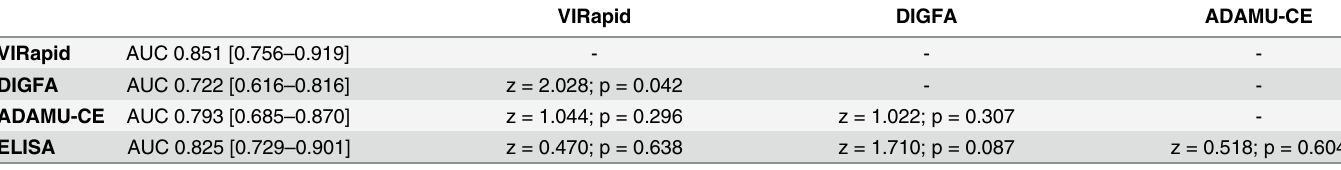
Table 4. ROC curves characteristics and results of comparison between tests. AUC = Area Under the Curve [95%